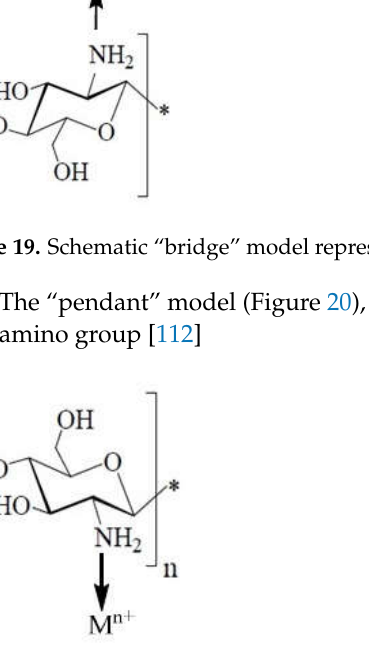
Figure 20. Schematic “pendant” model represented according to